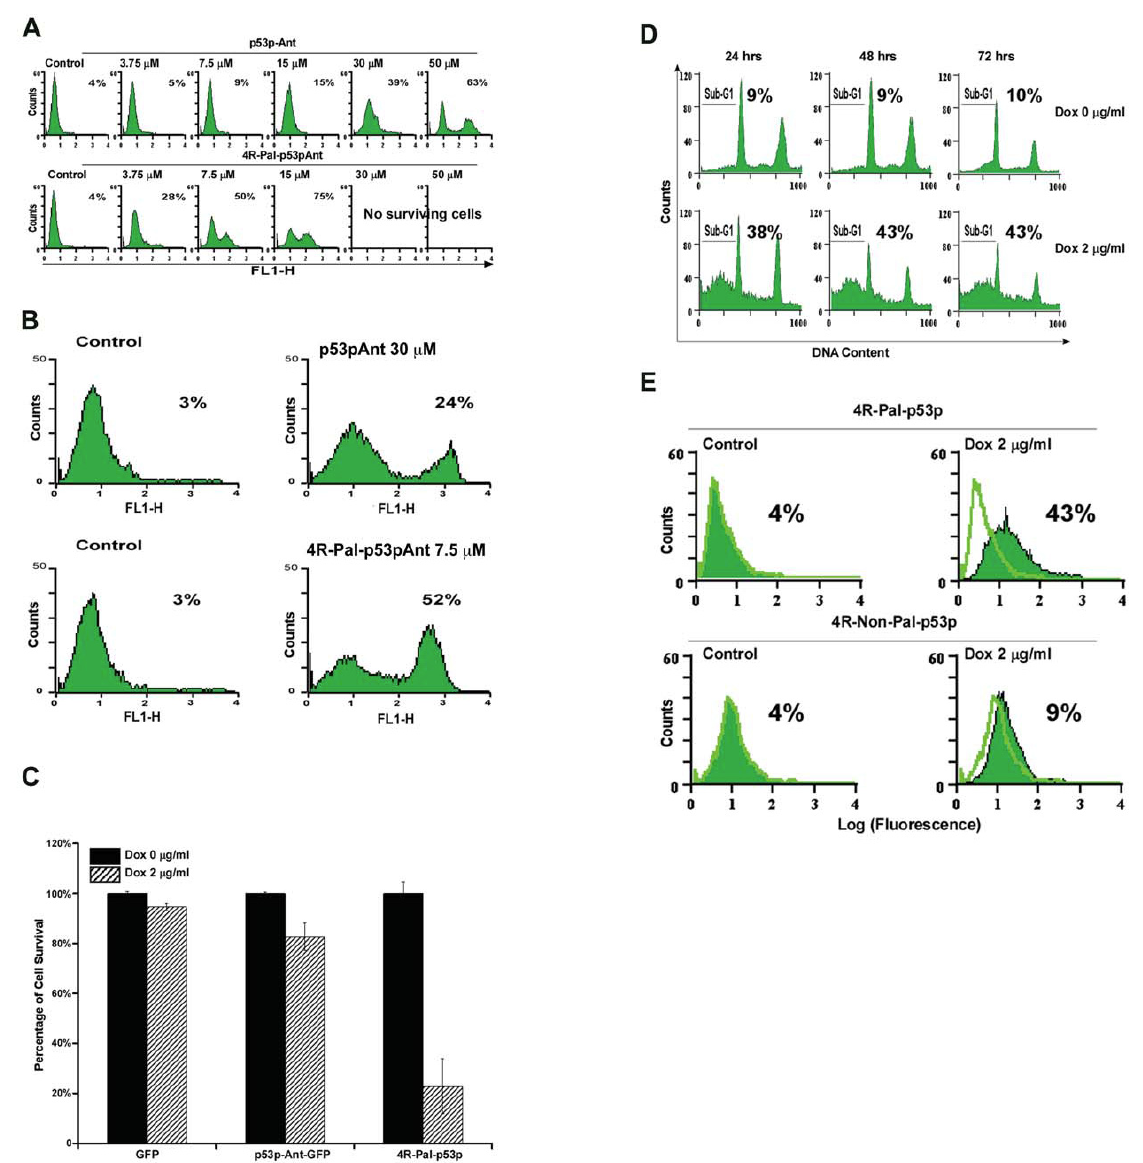
Figure 2. ( A ) Effect of exogenous 4R-Pal-p53p-Ant in cancer cell lines. MB468 human breast cancer cells (mutant p53 R273H) were exposed for 6 h to control (no peptide) or to either the monomeric p53pAnt (aa 361–382) or to the His tagged 4R-Pal-p53p-Ant. Annexin V staining was assayed by flow cytometry. The percent within each graph represents the percent of apoptotic cells. At concentrations ≥ 30 µM 4R-Pal-p53p-Ant produced 100% cell kill. ( B ) A431 Human squamous carcinoma cells (mutant p53 R273H) treated with either p53pAnt or 4R-Pal-p53pAnt . 4R-Pal-p53pAnt (7.5 µM) was 8.7 fold more potent on an equimolar basis by Annexin V assay for inducing apoptosis than p53pAnt (30 µM) when exogenously delivered. Similarly, endogenous expression of 4R-Pal-p53p produced 43% cell kill while endogenous expression by a Dox inducible promoter for monomeric p53p-Ant-GFP had no significant cell death. ( C ) Effect of endogenous, regulated expression of the 4R-Pal-p53p on cell viability. MB468 cells with mutant p53 (R273H), engineered to express GFP or p53p-Ant- GFP or 4R-Pal-p53p under the control of a Tet-On promoter, were cultured without or with 2 µg/mL Dox for 48 h and analyzed by trypan blue. The tetrapeptide and monomeric p53p produced 80% and 15% apoptosis, respectively. ( D ) Effect of endogenous expression of the 4R-Pal-p53 on apoptosis . MB468 cells with mutant p53 (R273H), were engineered to express the 4R-Pal-p53p under the